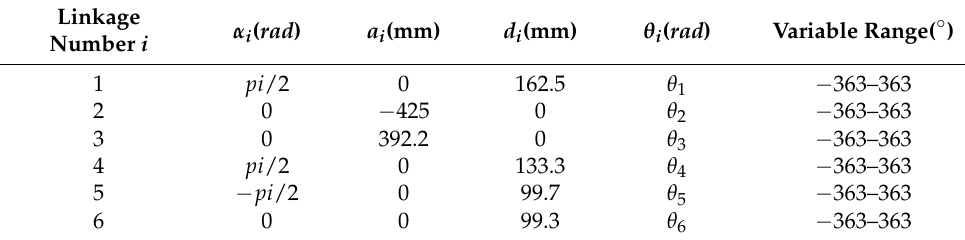
Table 5. Sequence of the positions of each joint of the robot arm.